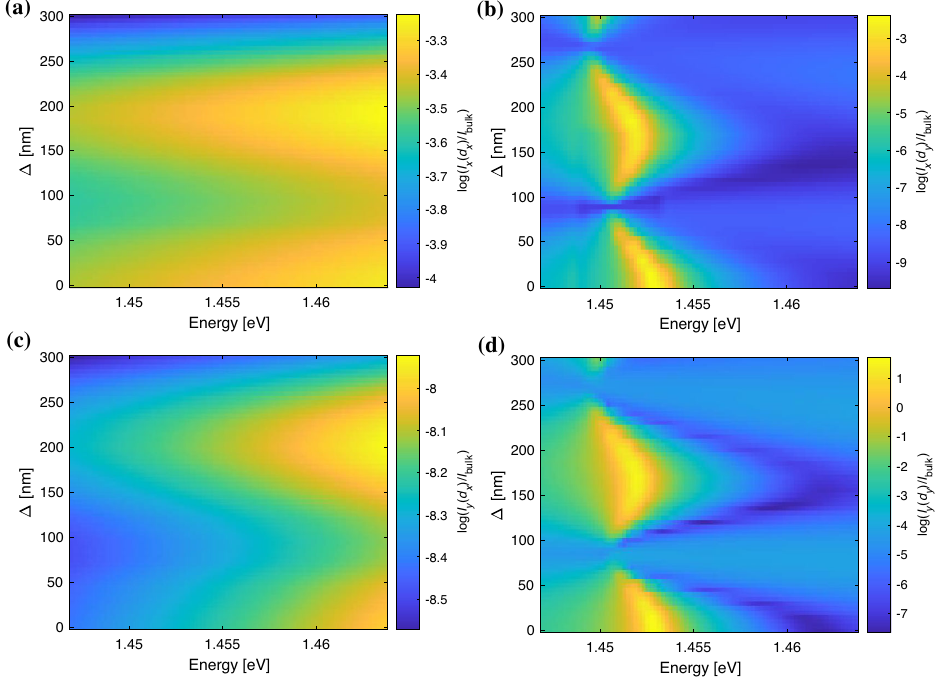
FIG. 14. 3D FEM modeled x - and y -polarized emission intensity components I function of the dipole emission energy and position. (a) The x -polarized emission intensity I polarized emission intensity I (d) The y -polarized emission intensity I bulk